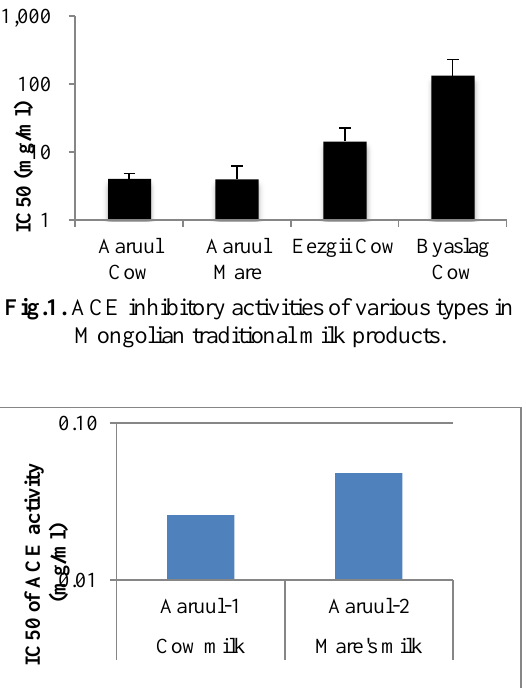
Fig. 2. Stability of angitensin I-converting enzyme (ACE) activity from aaruul (cow’s milk, mare’s milk)